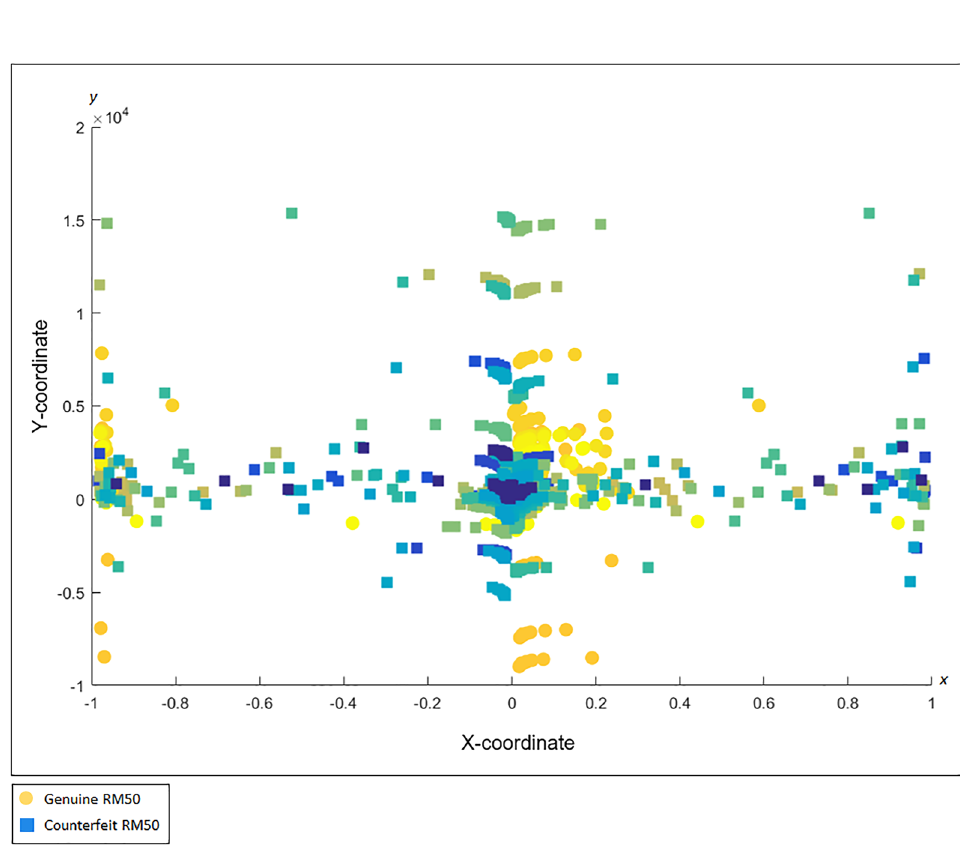
Figure 11. Coordinated FACS of Genuine and Counterfeit RM50. This figure was generated using MATLAB version R2016a (Mathworks, Natick, MA; https:// www. mathw orks.